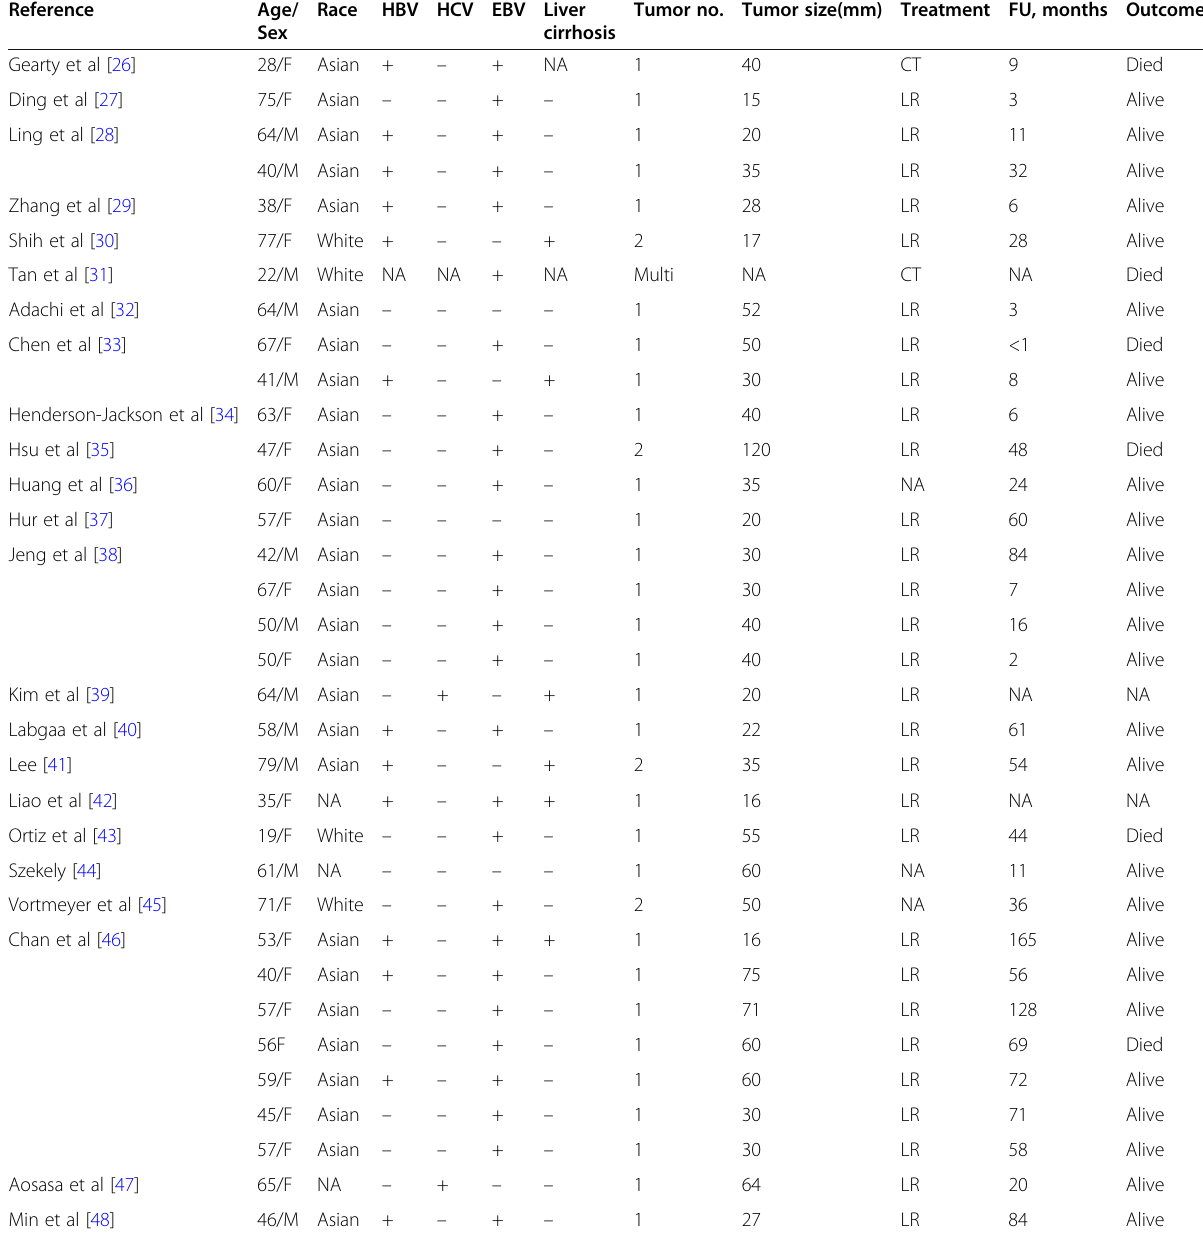
Table 5 Reported cases of